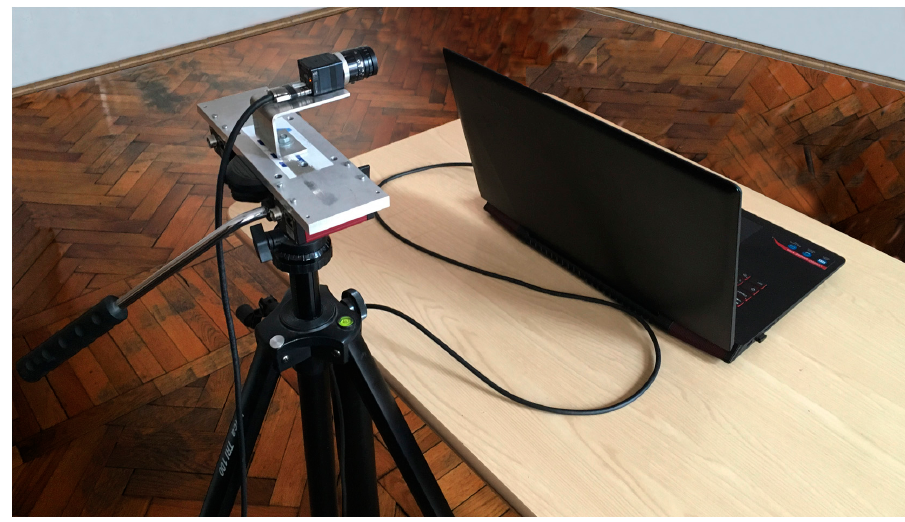
Figure 12. Physical system: the high speed Ximea camera is placed on a tripod and captures high temporal resolution frames of the subject. Table 5. Physical system performance under various illumination setting.